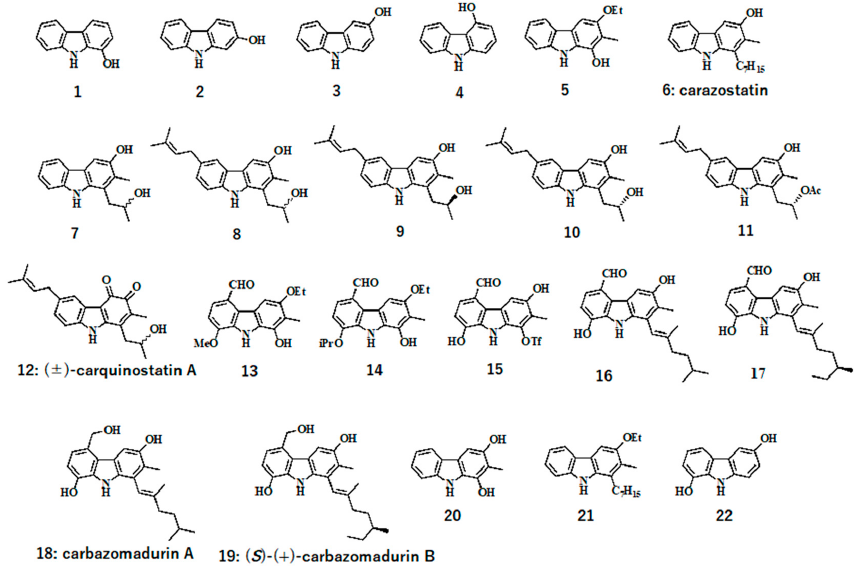
Figure 1. Structures of carbazole derivatives.